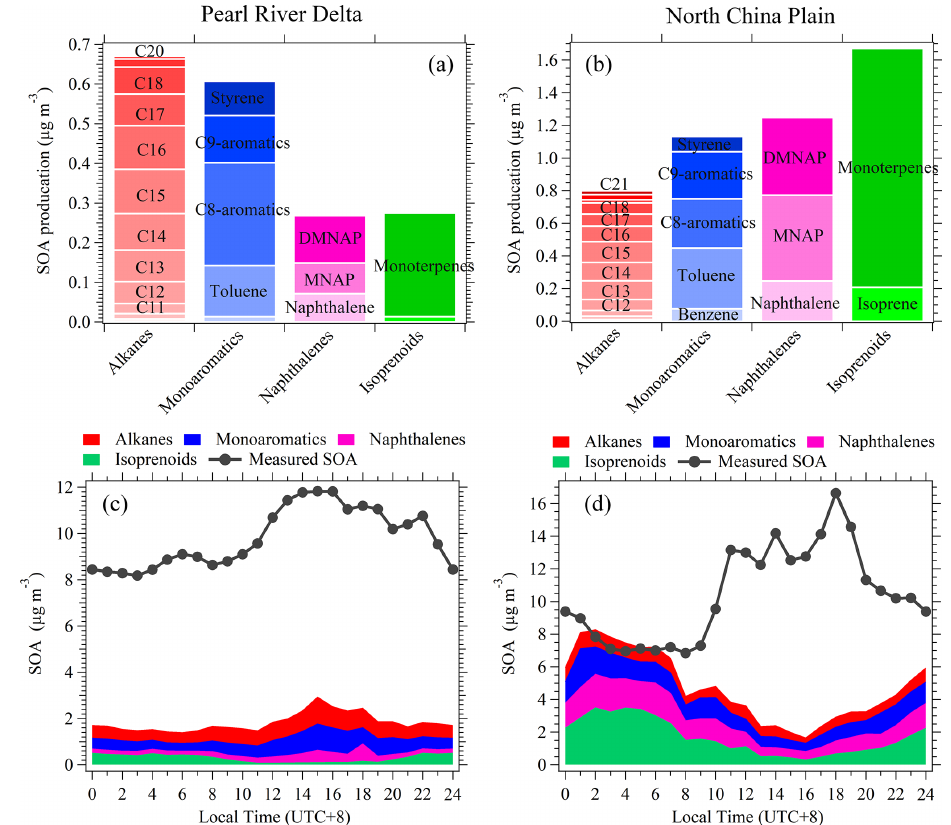
Figure 9. The mean concentrations of SOA produced from higher alkanes (C8–C21 alkanes), monoaromatics (benzene, toluene, C8 aro- matics, C9 aromatics, and styrene), naphthalenes (naphthalene, methylnaphthalenes, and dimethylnaphthalenes), and isoprenoids (isoprene and monoterpenes) in PRD (a) and NCP (b) . Diurnal variations of SOA production from higher alkanes, monoaromatics, naphthalenes, and isoprenoids as well as the measured SOA concentrations in PRD (c) and NCP (d) .